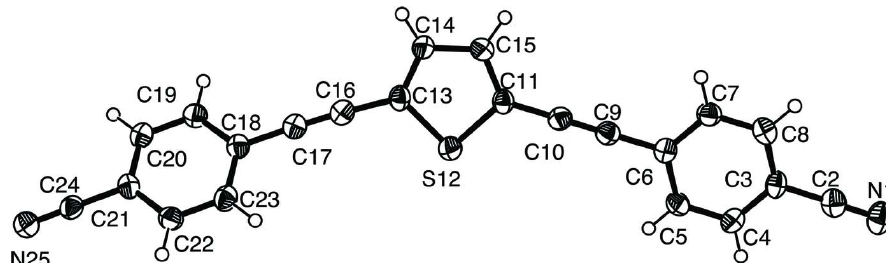
Figure 1 The molecular structure of (I) with 50% probability displacement ellipsoids.